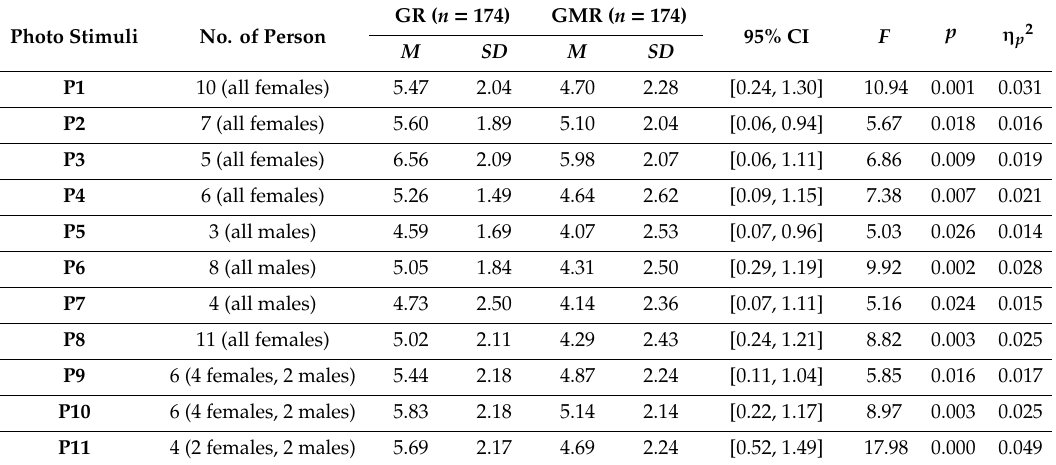
Table 1. Comparisons between the GR and GMR from Study Ia ( n =